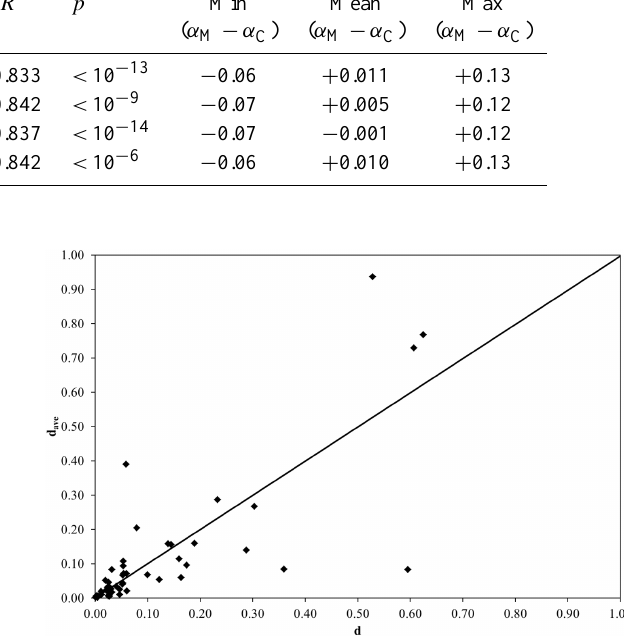
Figure 12. Scatter plot reporting d (obtained from T GS ) vs. d AVE (obtained from T GS-AVE )